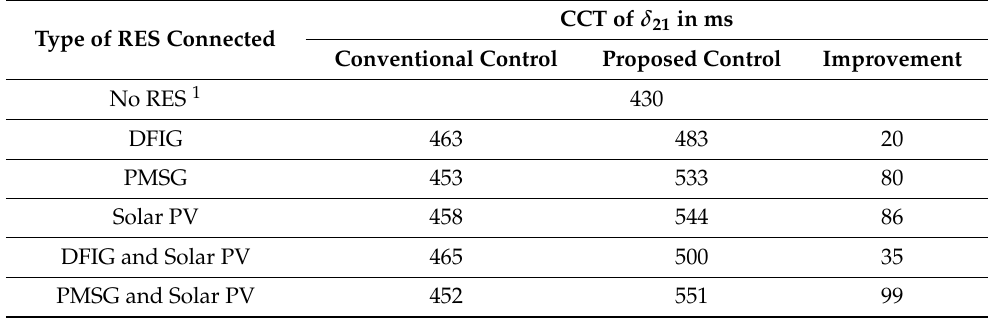
Table 1. CCT of generator-2 with conventional and proposed control when connected to different RES. Type of RES